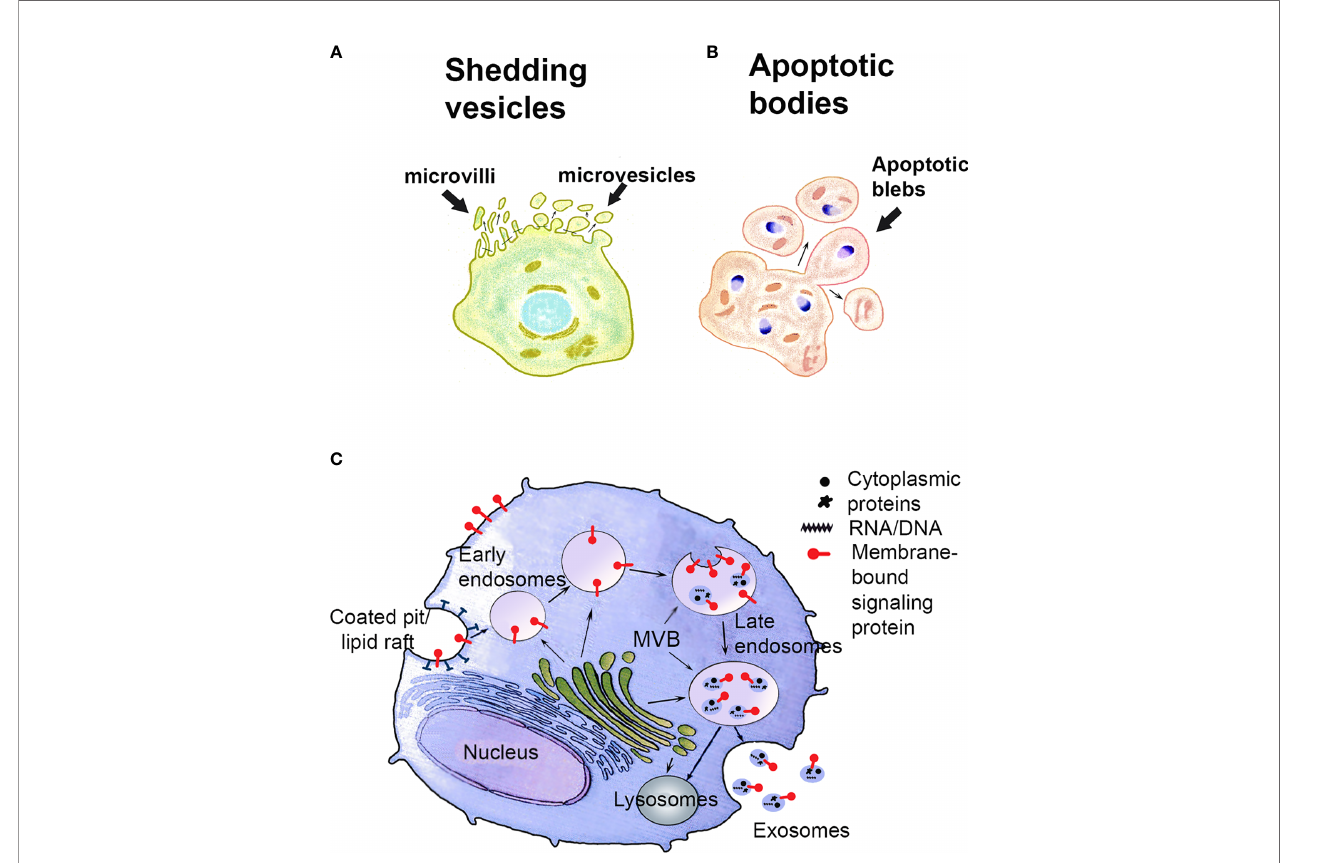
FIGURE 1 | Schematic presentation of the biogenesis of shedding vesicles (A) , apoptotic bodies (B) and exosomes (C) . (A, B) Shedding vesicles such as STBM and shed microvilli and apoptotic bodies are produced by blebbing of the plasma membrane. (C) Recycled or newly synthesized proteins are sorted to the limiting membrane of multivesicular bodies (MVB). Exosomes are produced by invagination of the MVB membrane. Exosomes carry on their surface the proteins sorted to the MVB membrane. The cargo inside comprises cytosolic proteins and nucleic acids. Exosome- fi lled MVB are either exocytotic, i.e. fuse with the plasma membrane and release their content as exosomes to the extracellular space or degradative, sending their content to lysosomes for degradation. Modi fi ed from ref.